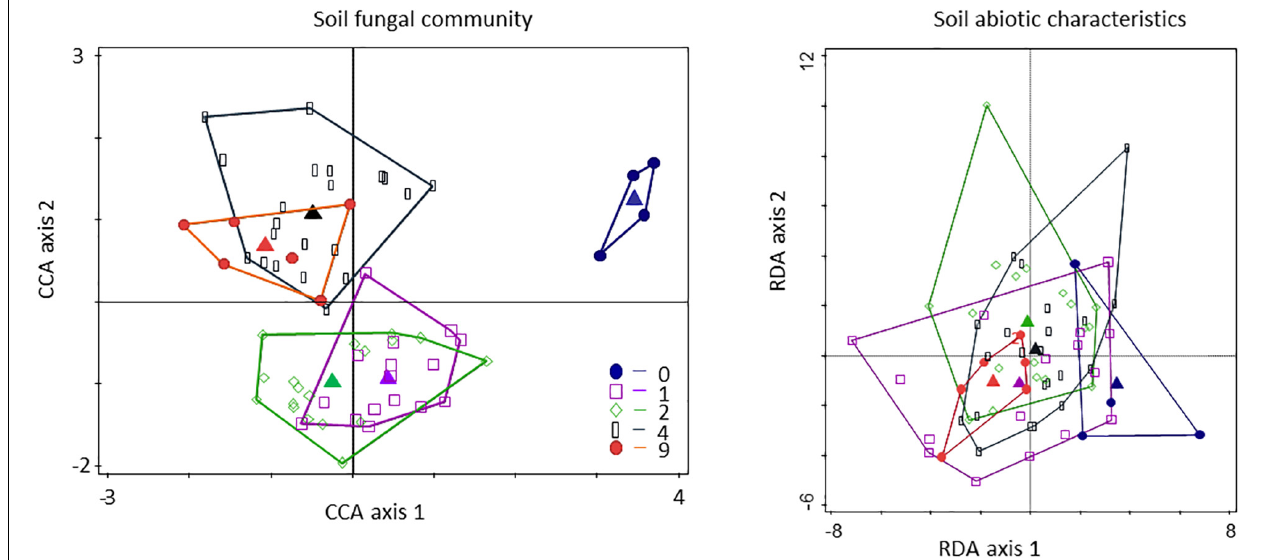
FIGURE 3 | Classified plot diagram (CCA) of soil fungi and soil abiotic characteristics (RDA) depicturing the separation of plots defined by the plant diversity treatment. For fungi score scaling is focused on T-RFLP scores. Symbols represent the individual plots (blue circles – plots without sown vegetation; purple squares – one species plots; green diamonds – two species plots; black rectangles – four species plots; red circle – nine species plots). Triangles represent the average relative composition of plots belonging to individual levels of a plant diversity (0, 1, 2, 4, 9 plant species). The distance between the triangles approximates the average dissimilarity of the plots with a certain diversity level as measured by their chi-square distance.